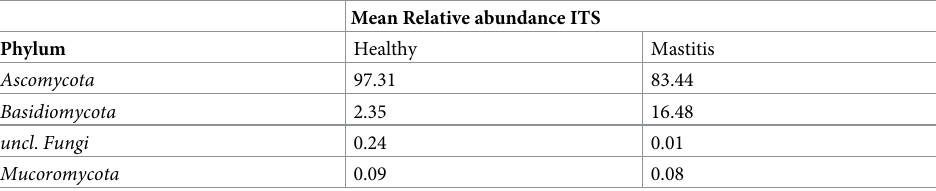
Table 4. Relative abundance of fungal population in healthy and mastitis camel milk at phylum level for ITS.